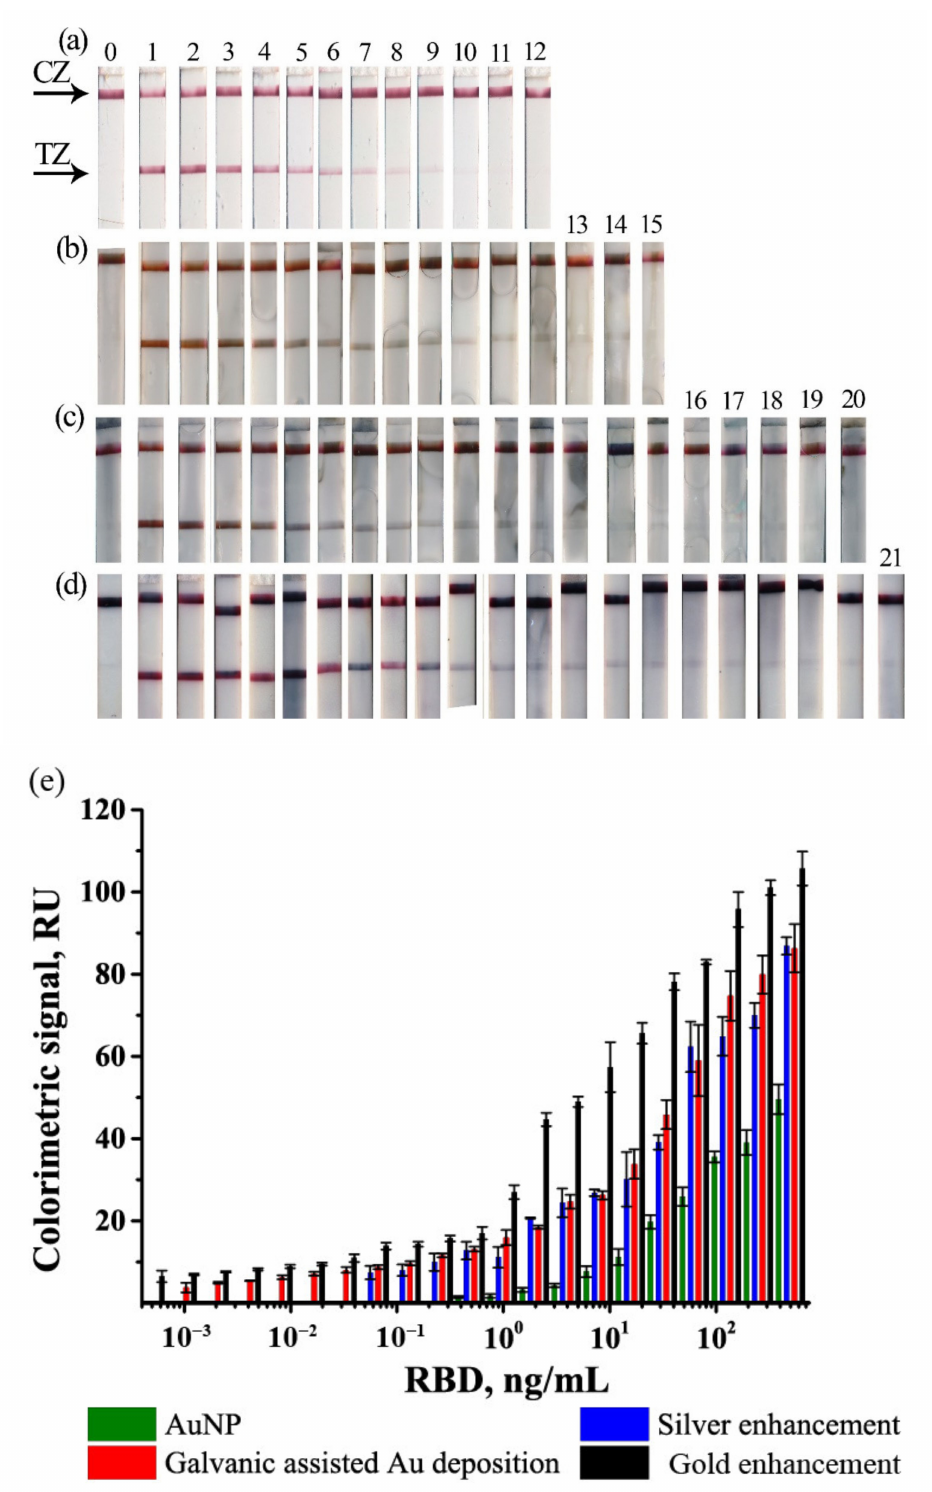
Figure 3. LFIA of RBD in artificially contaminated saliva. ( a ) Test strips with Au NPs; ( b ) Test strips after silver enhancement; ( c ) Test strips after galvanic-assisted Au deposition; ( d ) Test strips after gold enhancement: the numbers above the test strips show the concentration of RBD in the probe, in ng/mL, equal to 500 (1), 250 (2), 125 (3), 62.5 (4), 31.2 (5), 15.6 (6), 7.8 (7), 3.9 (8), 1.95 (9), 0.98 (10), 0.49 (11), 0.,24 (12), 0.12 (13), 0.06 (14), 0.03 (15). Concentration of RBD, in pg/mL, is equal to 15 (16), 7.5 (17), 3.8 (18), 1.9 (19), 0.9 (20), 0.05 (21), blank (0); ( e ) Dependences of the colorimetric signal in TZs versus RBD concentrations for various LFIA